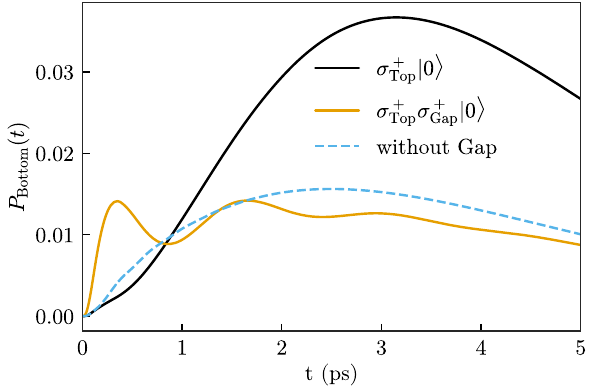
Figure 5: Population of Bottom for two-photon emission (black line) and one-photon emission (orange line) when Top and Bottom have = 1.142 eV and Gap is detuned 𝛿𝜔 = − 3.78 frequencies 𝜔 0